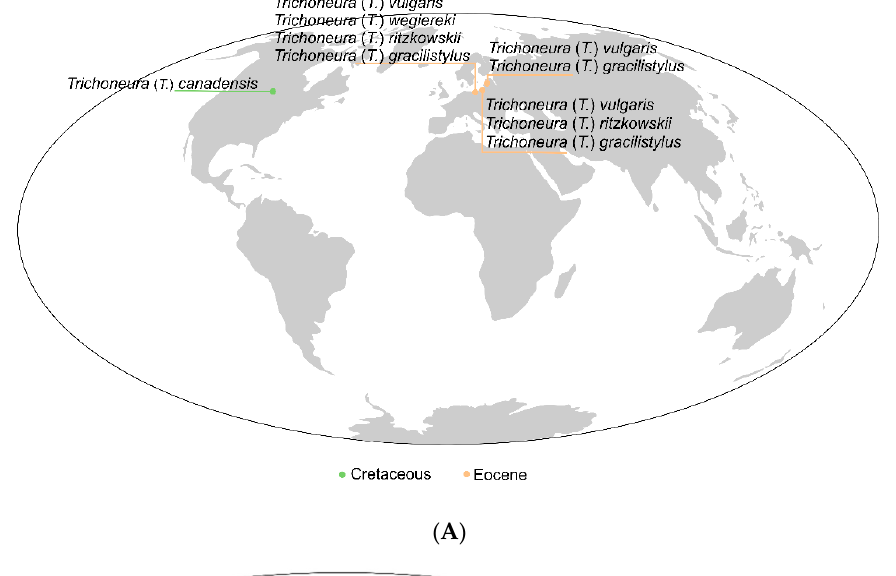
9 of 12 . Figure 5. Wing venation of extinct species of the genus Trichoneura. Abbreviation: vertical lines indicate the line ends – grey lines tips of A 1 and A 2 ; red line, tip of Sc; yellow tip of R 1 . The draw- ings are redrawn after [1,6–9]. It is also worth noting that all fossil species of the genus Trichoneura , both those known from the Cretaceous and the Eocene, have been found in the northern hemisphere,